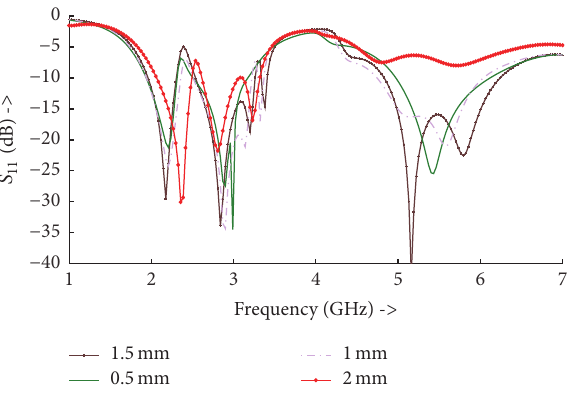
Figure 6: Reflection coefficient of different overlapping size. Figure 7: Reflection coefficient for different lengths of